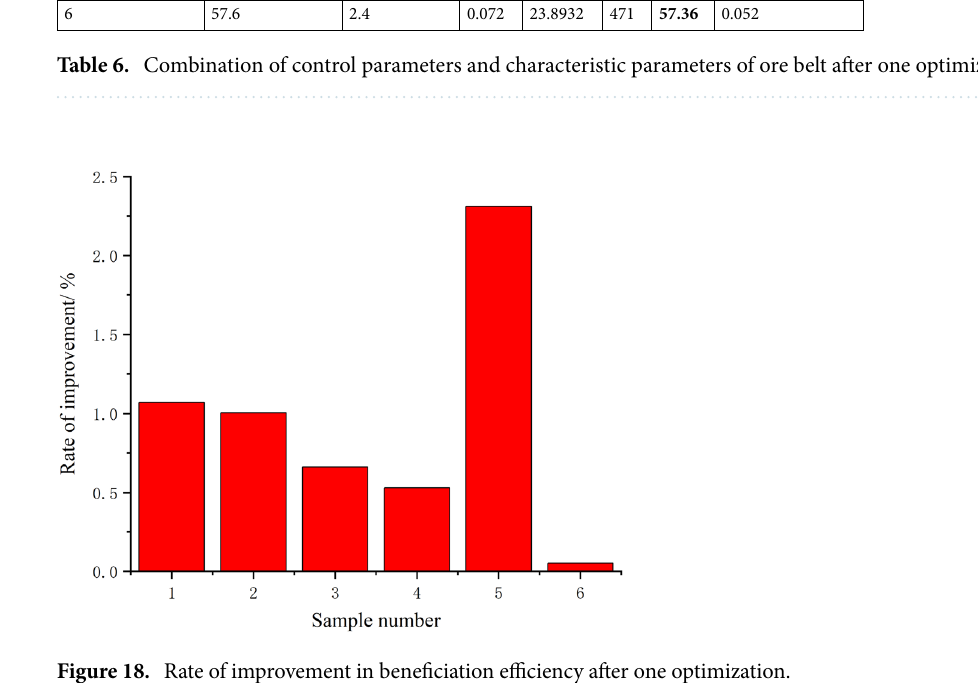
Figure 18. Rate of improvement in beneficiation efficiency after one